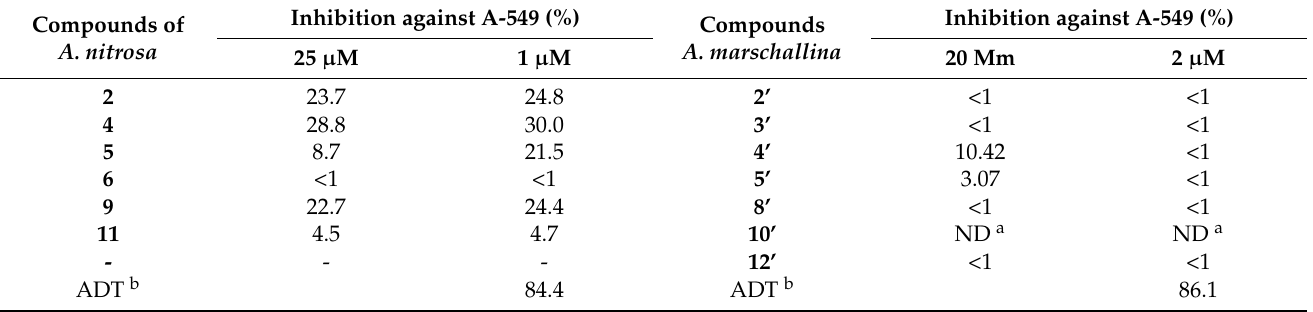
Table 3. Cytotoxic activities of isolated compounds from A. nitrosa and A. marschalliana against the A-549 cell line.